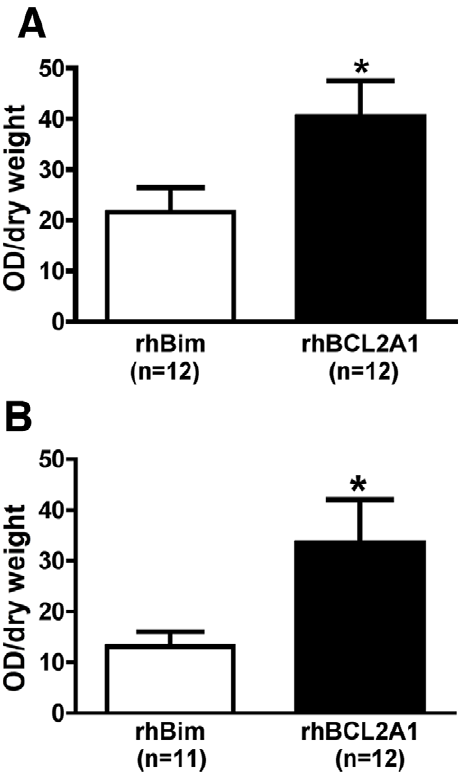
Figure 4. Treatment with rhBCL2A1 at the time of or following reperfusion protects hind limb skeletal muscle from I/R injury. Mice were subjected to tourniquet ischemia for 90 minutes, and then treated with subcutaneous rhBCL2A1 or rhBim (1 m g/mouse) at the time of reperfusion (A) or 4 hours after the start of reperfusion (B). Tissue viability was measured the following day by MTT assay (see methods section). Tissue viability was significantly greater in the rhBCL2A1-treated mice compared with the rhBim-treated mice (* p , 0.05).